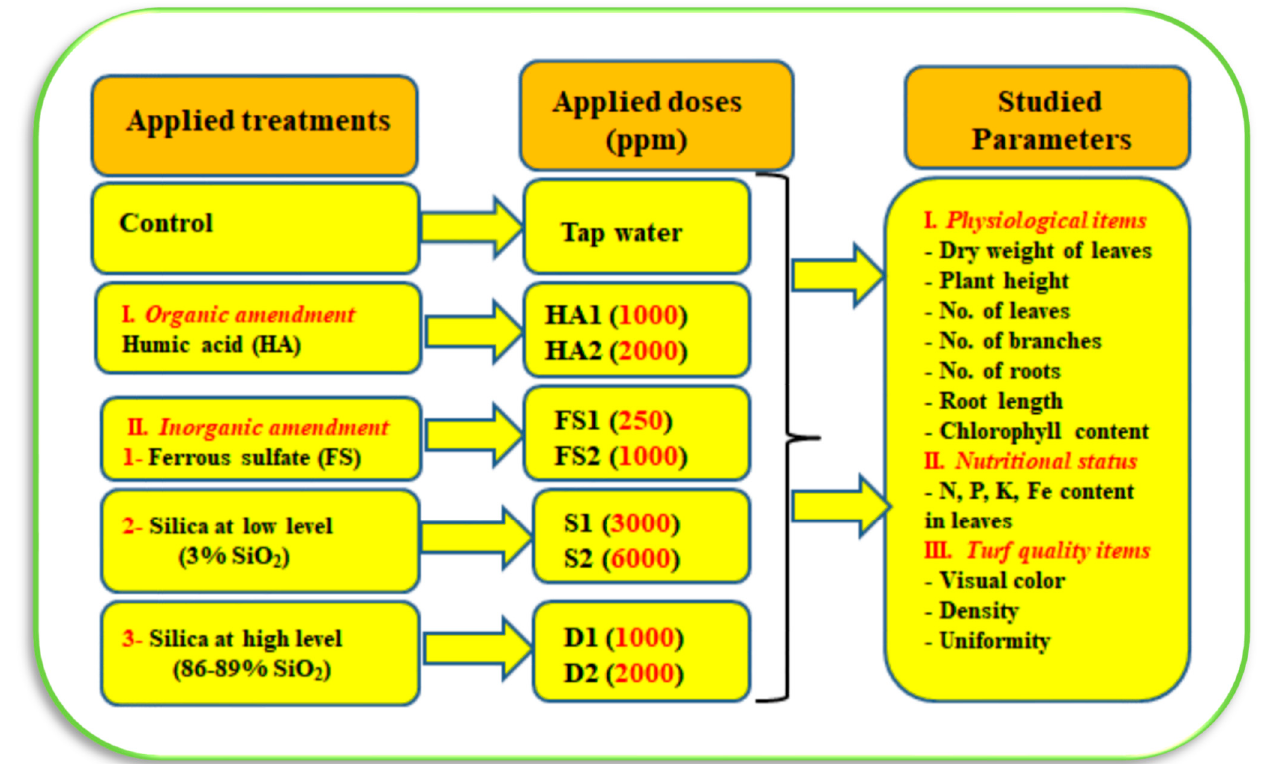
Figure 2. Overview of the experimental design including the main treatments, different applied doses of each treatment, and studied measurements.